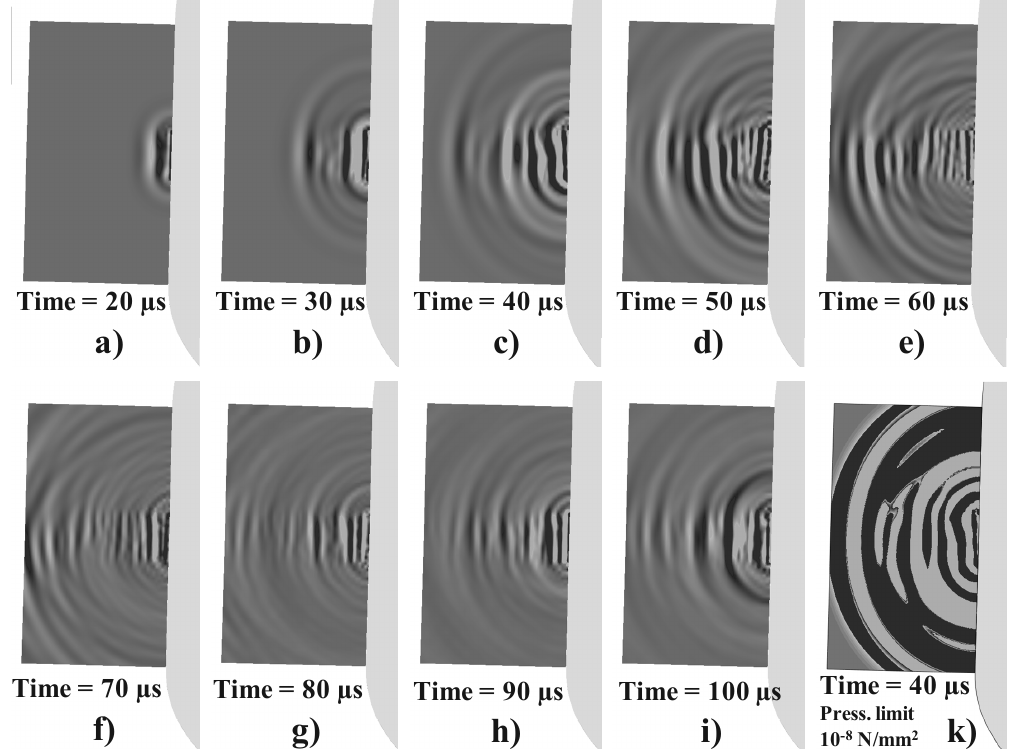
Figura 16: Mappe di pressione acustica nella sezione centrale della porzione di aria tra la superficie della rotaia e il trasduttore in nove istanti differenti.